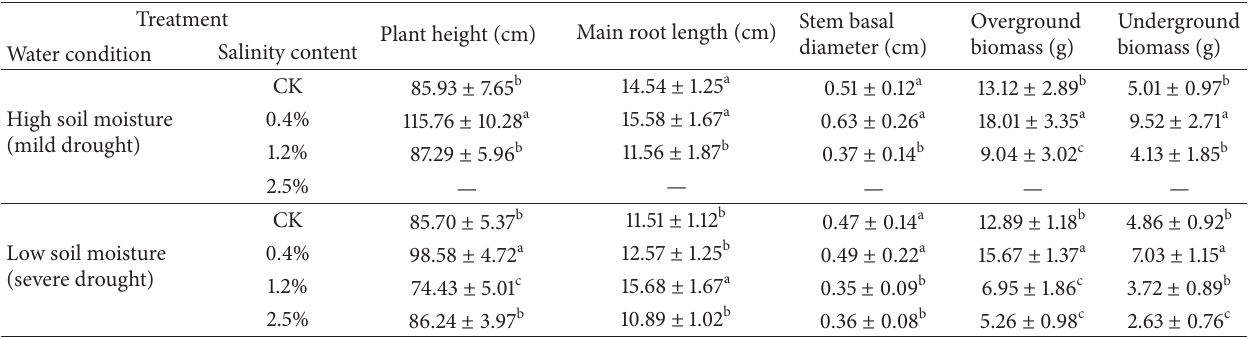
Table 1: Effects of Tamarix chinensis growth and biomass conditions with different salt and drought stresses